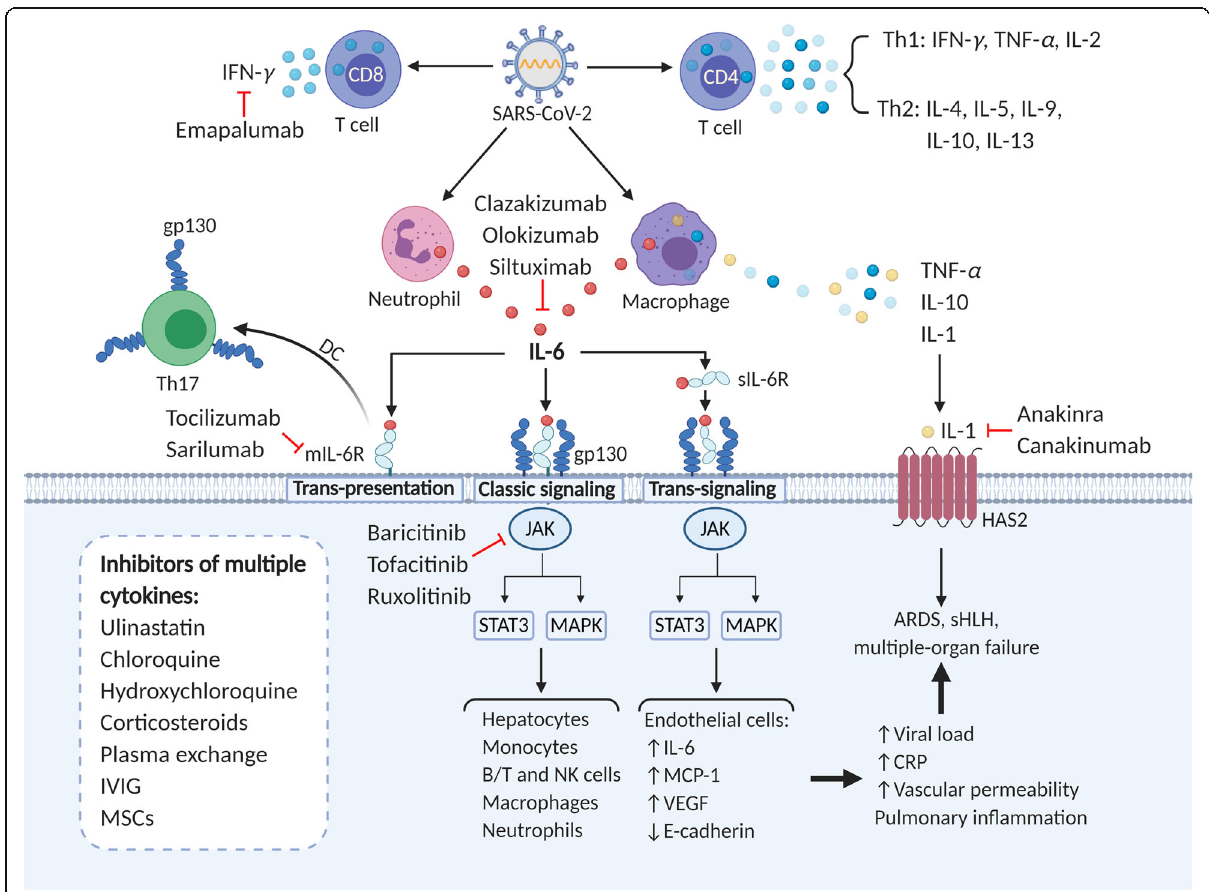
Fig. 2 Cytokine release syndrome in COVID-19 and relevant therapeutic options. CRS is commonly observed in severe COVID-19 patients involving an excessive production of various inflammatory cytokines. SARS-CoV-2 infection initiated increased secretion of both Th1 cell cytokines (IL-2, IFN- γ , TNF- α ) and Th2 cell cytokines (IL-4, IL-5, IL-9, IL-10, IL-13). CD8 + T cells may predominantly produce IFN- γ . Activation of macrophages and neutrophils may also account for the generation of multiple cytokines, such as IL-6, IL-1, IL-10, TNF- α , etc. among which IL-6 is the predominant component in causing CRS. IL-6 can induce CRS through three different signaling pathways: classic signaling, trans-signaling and IL- 6 trans-presentation. Three pathways all function with the formation of a hexameric complex including IL-6R (both mIL-6R and sIL-6R) and gp130, leading to the activation of downstream intracellular JAK- MAPK and JAK- STAT3 signaling pathways. Later on, cells expressing mIL-6R including monocytes, macrophages, etc. and endothelial cells that do not express mIL-6R are overactivated to accelerate secretion of cytokines, which cause increased viral load, CRP and permeabilization with subsequent ARDS, sHLH and multiple-organ failure. Apart from IL-6, IL-1 may also drive the occurrence of ARDS in COVID-19 patients by inducing HAS2. To ameliorate CRS, we can use inhibitors of multiple cytokines including chloroquine and corticosteroids, or use specific inhibitors targeting IL-6, IL-6R, IL-1, JAK and IFN- γ . mIL-6R: membrane IL-6 receptor; sIL-6R: soluble IL-6 receptor; DC: dendritic cell; HAS2: hyaluronan-synthase-2; IVIG: intravenous immunoglobulin; MSCs: mesenchymal stem